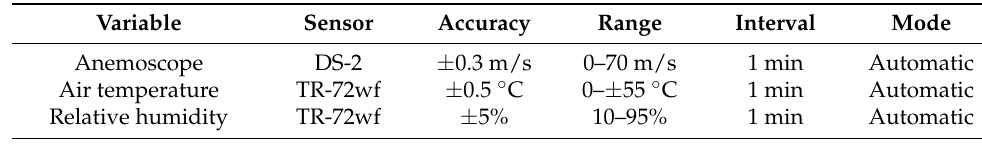
Table 2. The specifications of the instruments that were used.